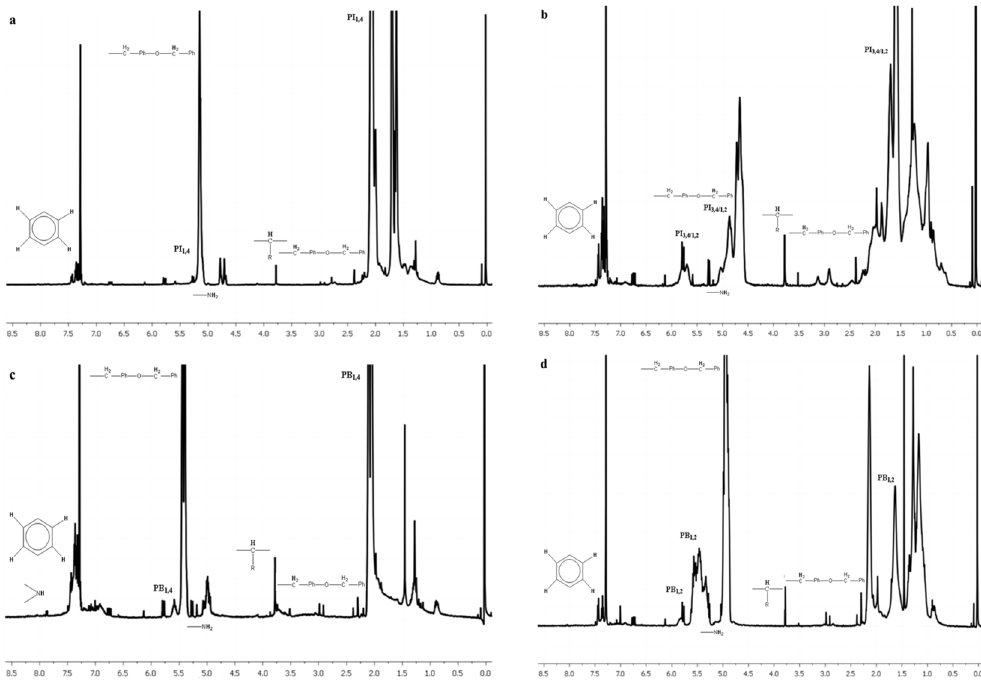
Figure 3. 1 H-NMR spectra of the synthesized materials corresponding to: ( a ) PI 1,4 - b -P(o-Bn-L-Tyr), ( b ) PI 3,4/1,2 - b -P(o-Bn-L-Tyr), ( c ) PB 1,4 - b -P(o-Bn-L-Tyr) and ( d ) PB 1,2 - b -P(o-Bn-L-Tyr).